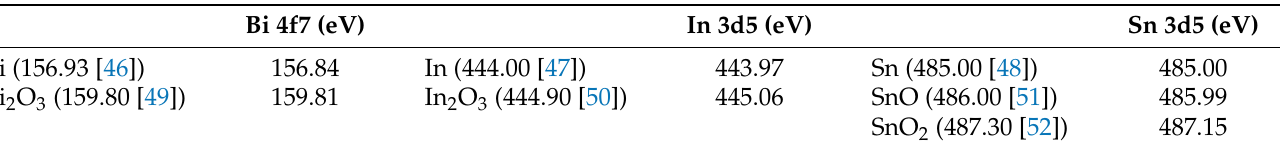
Figure 2. XPS binding energy results with the oxide assignments according to the referenced values included in Table 2 for: ( a ) Bismuth, ( b ) Indium and ( c ) Tin. Table 2. Binding energy values (eV) corresponding to the fitted curve peaks presented in Figure 2 (reference values along with the corresponding bibliographical sources are included for each component in